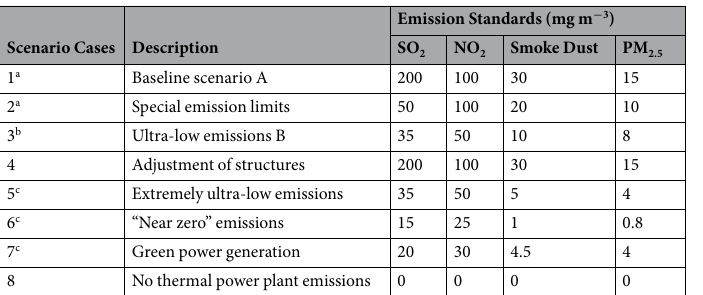
Table 1. Emission control standards of different cases for thermal power plants in the BTH region. a See http:// kjs.mep.gov.cn/hjbhbz/bzwb/dqhjbh/dqgdwrywrwpfbz/201109/W020130125407916122018.pdf. b See http:// www.zhb.gov.cn/gkml/hbb/gwy/201409/t20140925_289556.htm. c Cases 5, 6, 7 are carried out only for the month of January over the domain d02 with the grid resolution 12